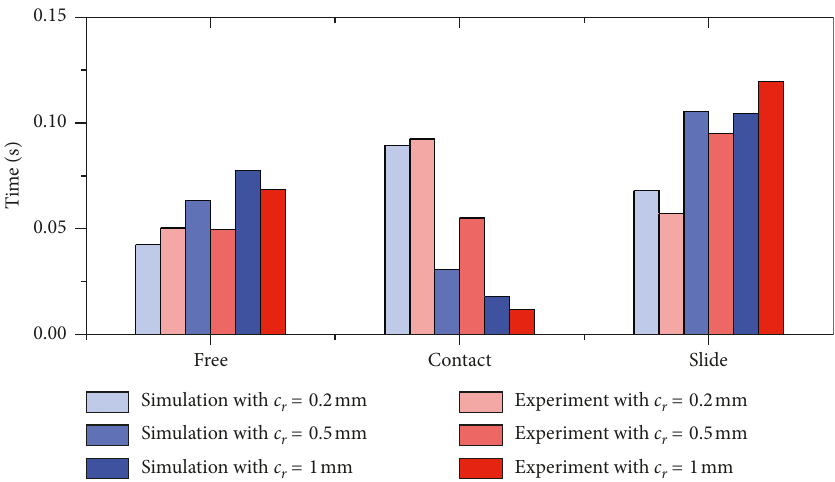
Figure 30: Statistical results of time in numerical and experimental studies with different c